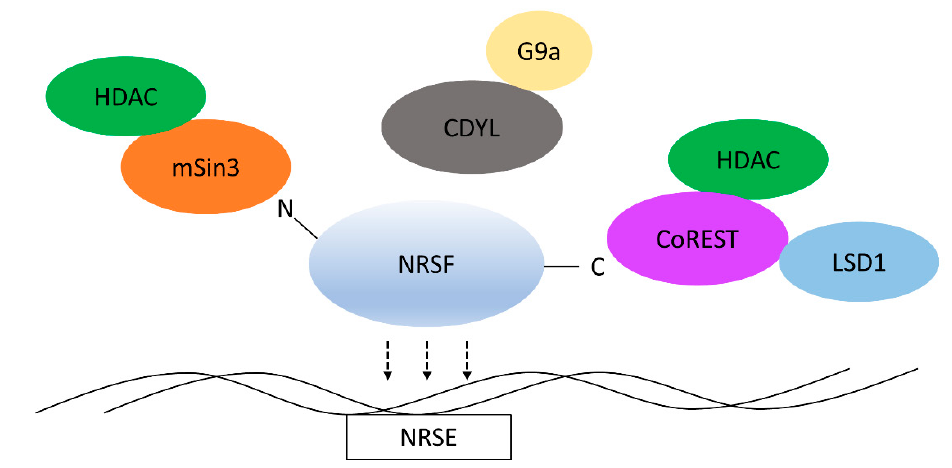
Figure 1. Neuron Restrictive Silencer Factor (NRSF) recruits multiple chromatin modifiers. The major function of NRSF is to recruit chromatin modifiers to neural genes by recognizing NRSEs throughout the genome. At the N-terminal end, NRSF recruits mSin3 enabling recruitment of histone deacetylase activity. Further histone deacetylase activity is conferred through recruitment of the major corepressor, CoREST, at the C-terminal end. Additionally, REST corepressor 1 (CoREST) recruits the histone demethylase LSD1. NRSF can also recruit the histone methylation activity of G9a. This is indirect through recruitment of chromodomain containing protein, chromodomain Y-like (CDYL).